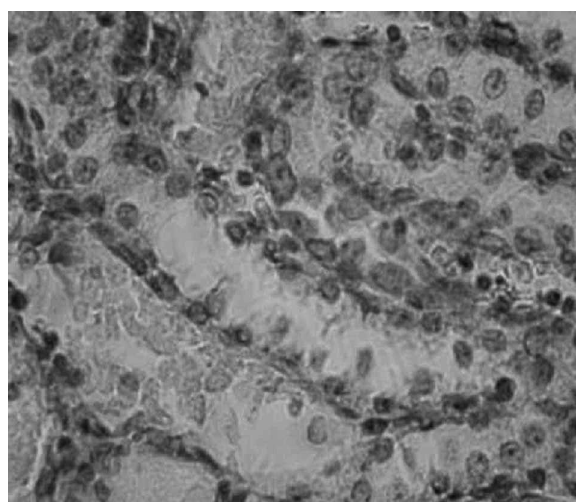
FIG. 3. Light micrograph of the corticomedulary region of a rat kidney treated with OOM after CDDP injection. Tubular necrosis was slight and in lesser extent than in Fig. 2. Note the significant diminution in the dequamation of tubular epithelial cells (hematoxylin and eosin, (cid:4) /